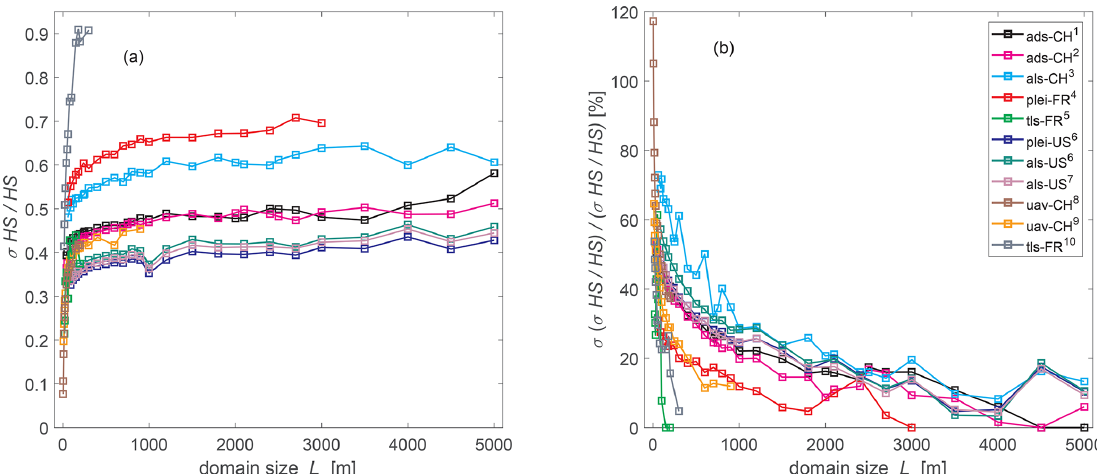
Figure 6. (a) Normalized standard deviation of HS as a function of domain size L for each data set separately. (b) Normalized percentage of standard deviation of panel (a) among each L . L ranges from 3m to 5km. Colors represent the different geographic regions, measurement platforms or acquisition dates (number) of the compiled data set as indicated in Sect. 2.1 to 2.4.